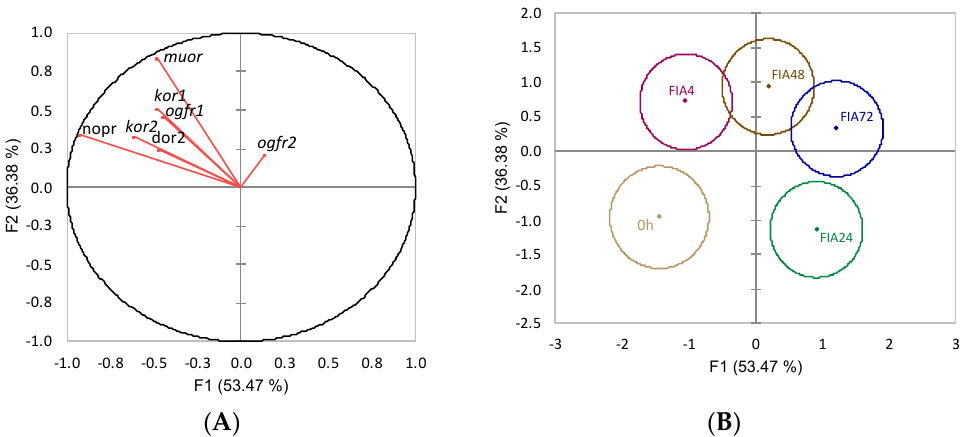
Figure 9. Telencephalic expression of opioid growth factor 1 ( ogfr1 , A ) and mu opioid receptors ( muor , B ) in undisturbed European seabass (t0h, ) or i.p.-injected with a sham solution (CTRL, □ ) or Freund’s Incomplete Adjuvant (FIA, ■ ) and sampled at 4, 24, 48, 72 h post-injection (means ± SD, n = 8). Different symbols (* and #) stand for significant differences between i.p.-injected groups and the undisturbed group (0 h). Capital letters stand for significant differences between stimuli. Lower- case letters indicate significant differences between sampling times. Further details in legend of